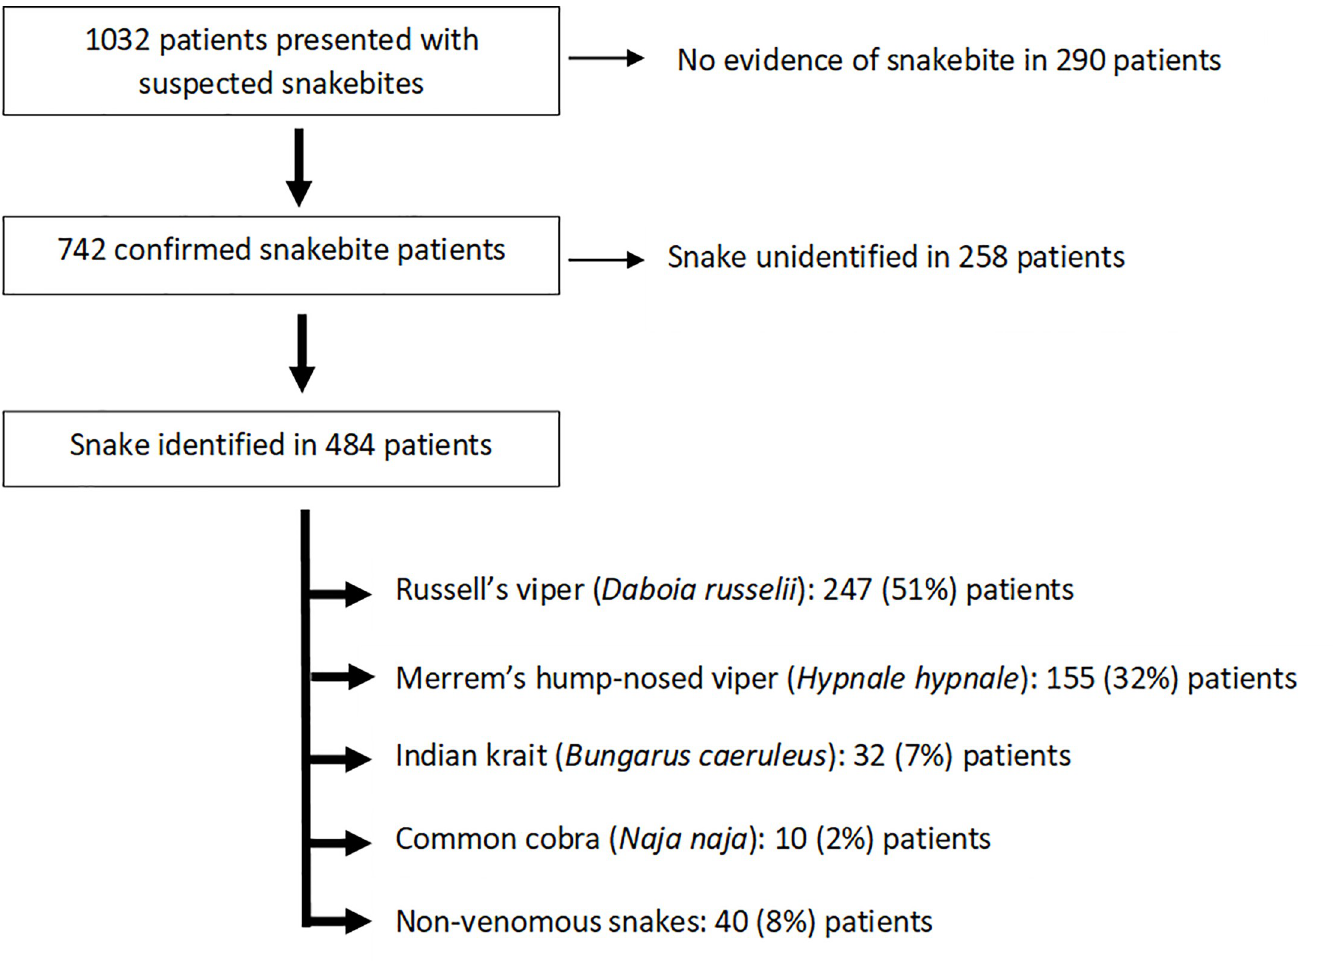
Fig 1. Flow diagram showing the enrolment of patients for the present study. https://doi.org/10.1371/journal.pntd.0008914.g001 Table 1. The clinical effects and outcomes of the 742 snakebite patients recruited for the